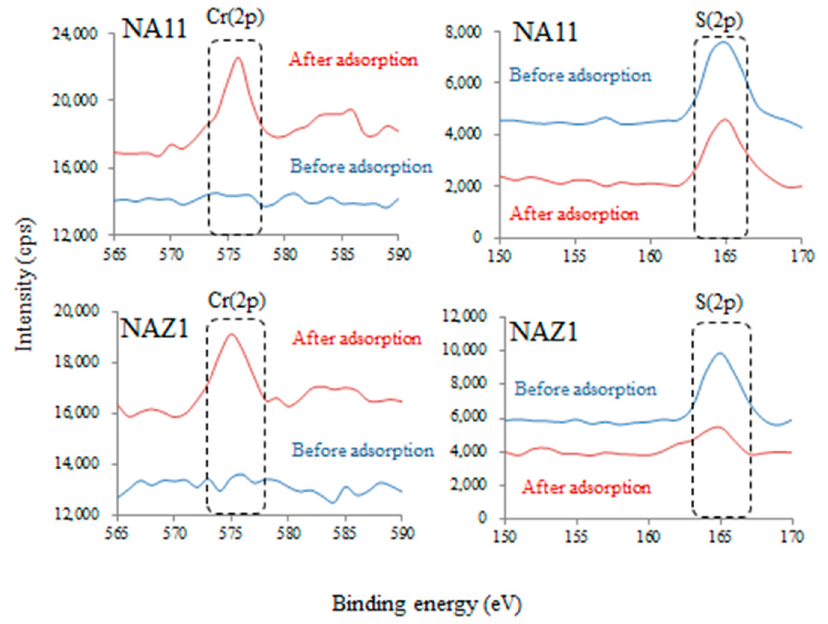
Figure 4. X-ray photoelectron spectrometry spectra of NA11 and NAZ1 before and after adsorption.